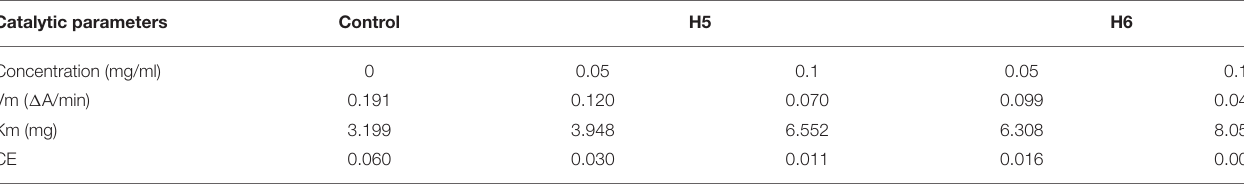
TABLE 4 | Kinetic constants of ACE-catalyzed reactions at different peptide concentrations.